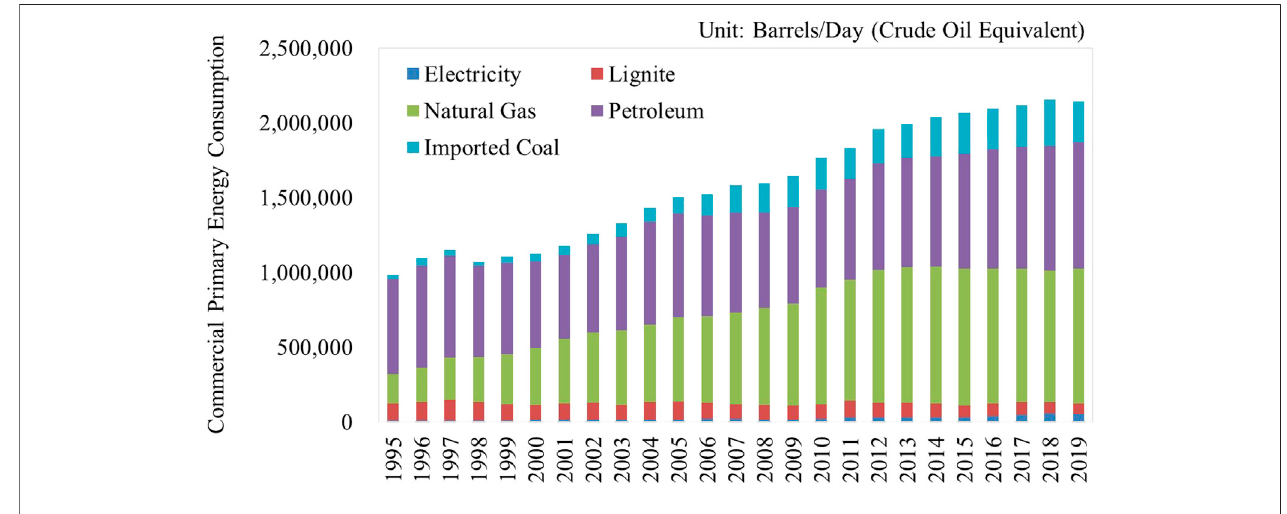
FIGURE 2 | Commercial primary energy consumption (EPPO, 2020b).